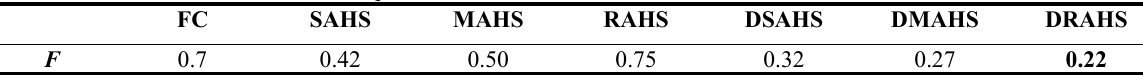
Decision maker's deviation value of the optimal